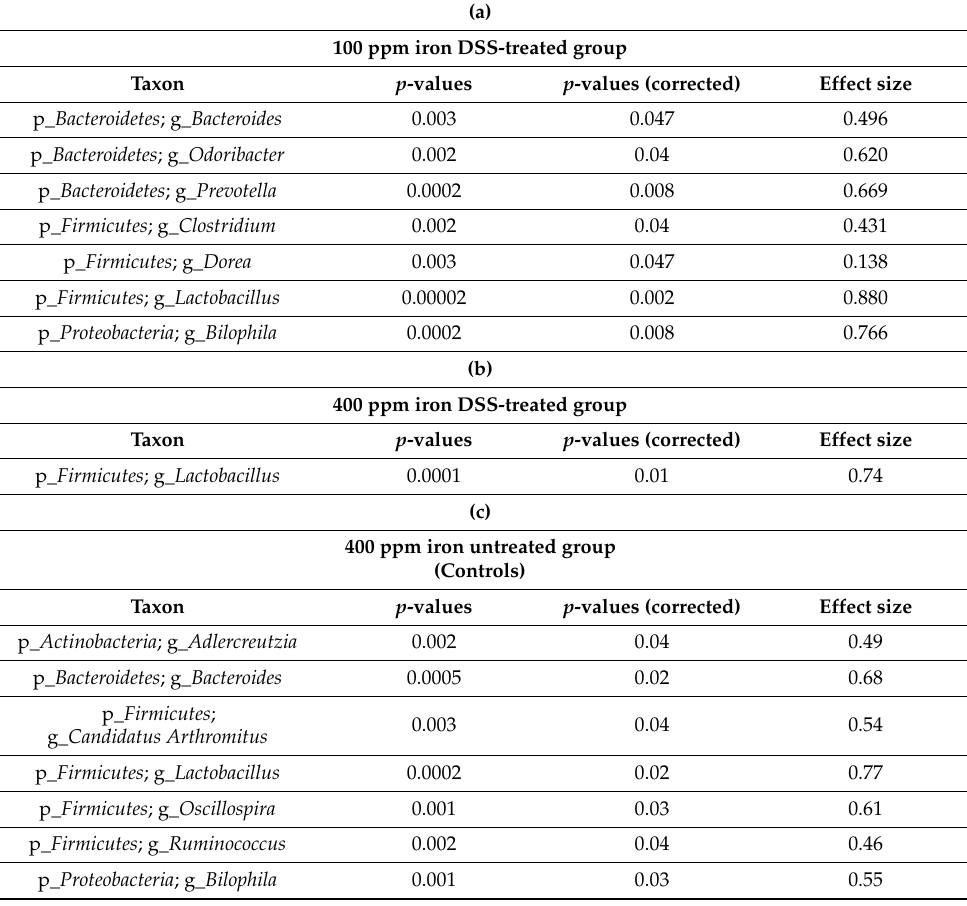
Table 1. ( a ): Genus-level taxonomic composition of fecal samples from 100 ppm iron DSS-treated mice (Day-1 vs. 21, 42, and 63 samples), ( b ) Genus-level taxonomic composition of fecal samples from 400 ppm iron DSS-treated mice (Day-1 vs. 21, 42, and 63 samples), ( c ) Genus-level taxonomic composition of fecal samples from 400 ppm iron untreated mice (Day-1 vs. 21, 42, and 63